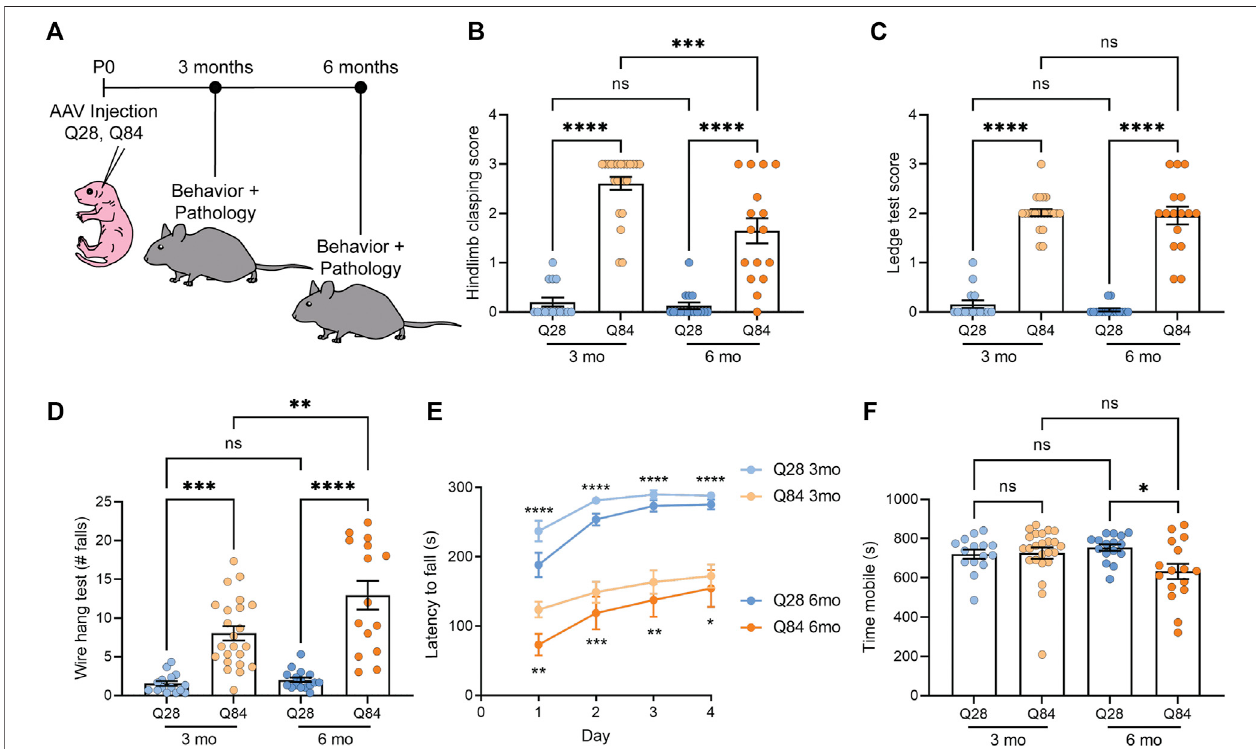
FIGURE 1 | SCA3 mice show ataxia-like behavioral defects. (A) Schematic showing the experimental timeline used to analyze the Q28 and Q84 mice. AAV was injected at P0 and mice were analyzed for both behavior and pathology at 3 or 6 months. (B) Hindlimb clasping scores for Q28 and Q84 animals at 3 and 6 months of age. (C) Ledge test scores for Q28 and Q84 animals at 3 and 6 months of age. (D) Number of falls in 2 min on the wire hang assay for Q28 and Q84 animals at 3 and 6 months of age. (E) Latency to fall (seconds) on the rotarod over four consecutivedays for Q28and Q84 animals at 3 and 6 monthsof age.Asterisks at the top of the graph refer to analysis of Q28 versus Q84 in the 3-months cohort, while asterisks at the bottom of the graph refer to the 6-month-old animals. (F) Time (seconds) spentmobileduringtheopen fi eldassayforQ28andQ84animalsat3and6 monthsofage.Forallpanels,errorbarsarethestandarderrorofthemean(SEM).* p ≤ 0.05, ** p ≤ 0.01, *** p ≤ 0.001, **** p ≤ 0.0001, ns = non-signi fi cant (1-way ANOVA with Tukey ’ s multiple comparisons test for (B - D , F) ; 2-way ANOVA with Sidak ’ s multiple comparisons test for (E)